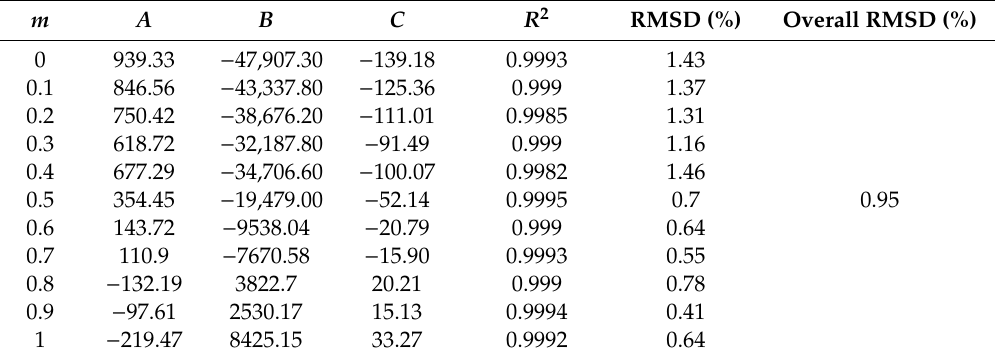
Table 6. The parameters of Apelblat model ( A, B and C ) along with R 2 and % RMSDs for FFA in various Carbitol + water combinations ( m ) d .